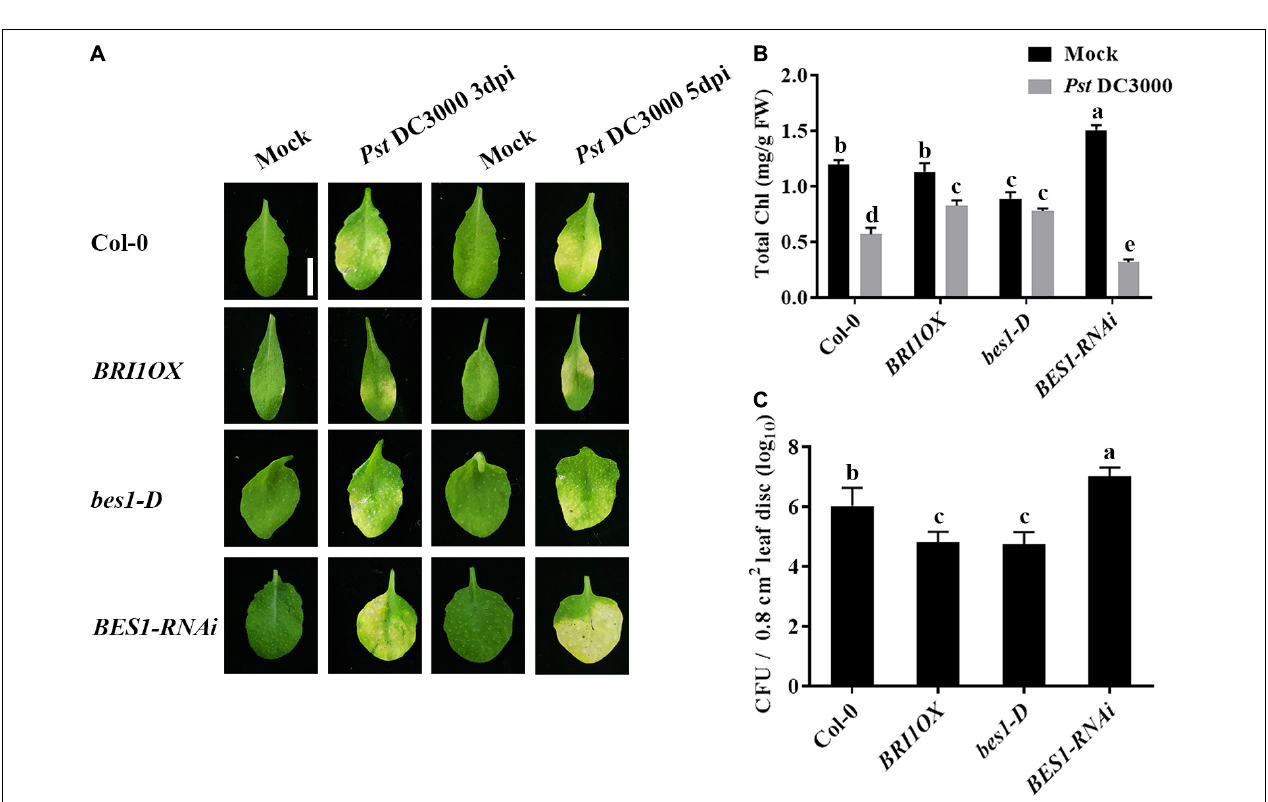
FIGURE 5 | Brassinosteroid signaling positively regulates plant defense. (A) Typical Pst DC3000 infection symptoms in Col-0, BRI1OX , bes1-D , and BES1-RNAi . Pictures were taken at 3 and 5 dpi, respectively. Bar, 1.00 cm. (B) Total chlorophyll content in inoculated leaves was detected in planta at 3 dpi. (C) Bacterial growth in the inoculated leaves was detected in planta. Bacteria were isolated from plants at 1 dpi and quantified with gradient dilution assays. Bars represent mean ± SD obtained from three biological replicates per genotype and time point, chlorophyll content or bacterial growth measured from five leaves of each genotype and treatment were pooled for one replicate. Significant differences ( P < 0.05) are denoted by different lowercase